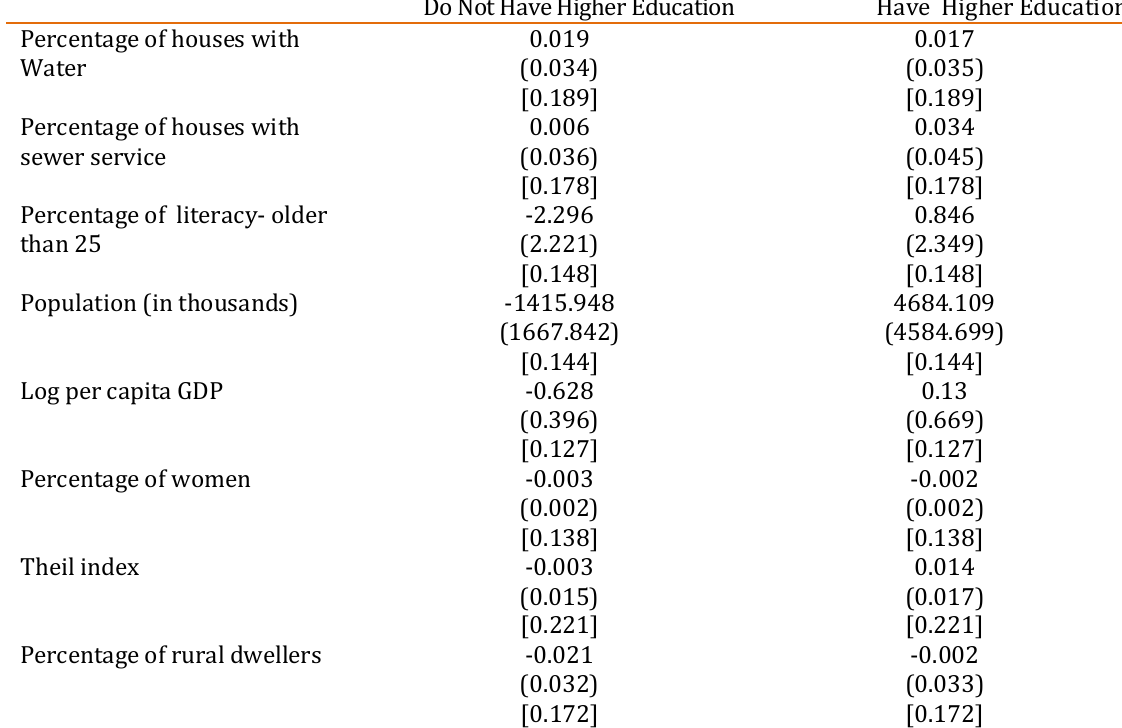
Table 03. Balance test for municipal characteristics by mayoral educational level Do Not Have Higher Education Have Higher Education Percentage of houses with